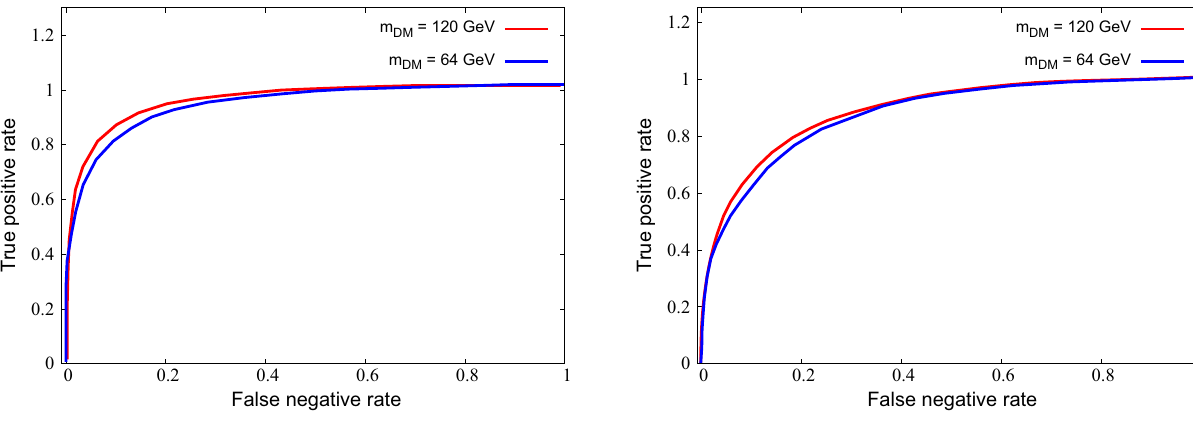
Fig. 19 ROC curves for two Dark matter masses in the b ¯ b + / E T final state with ANN (left) and